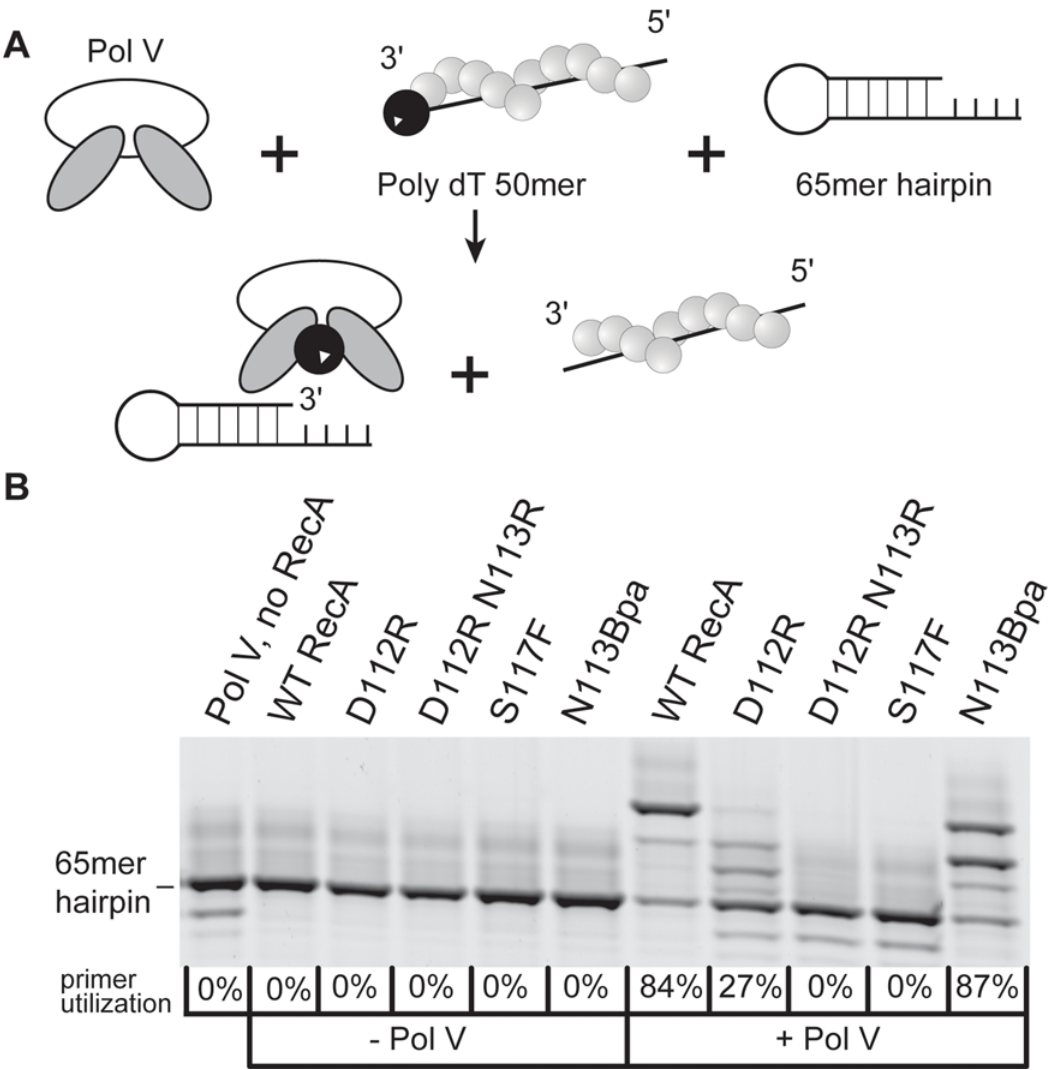
Fig 5. RecA variant D112R N113R is defective in DNA polymerase V activation. (A) Schematic of DNA synthesis by pol V transactivated by RecA * . (B) In pol V reaction buffer, 5 mM DTT, 2 mM ATP γ S, 2 μ M poly (dT) 50 , and 20 μ M RecA were incubated at 37°C for 10 minutes to allow for formation of RecA *